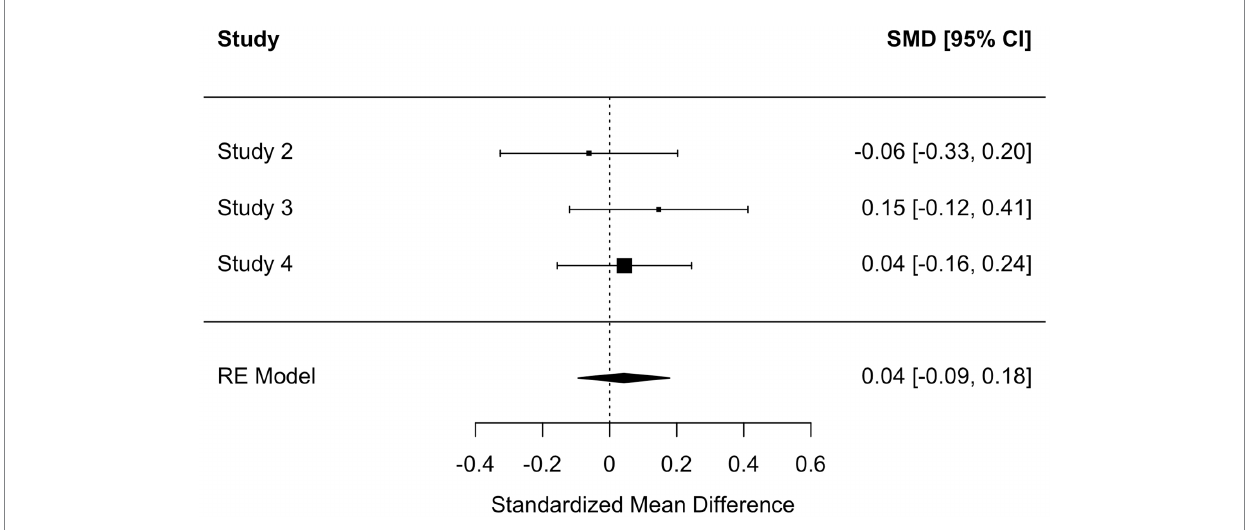
FIGURE 4 Forest plot of random effects meta-analysis of pro-environmental intentions between conditions (personal vs. neutral) across Studies 2, 3, and 4. Q (2) = 1.18, p = 0.554, I 2 = 0 [0,